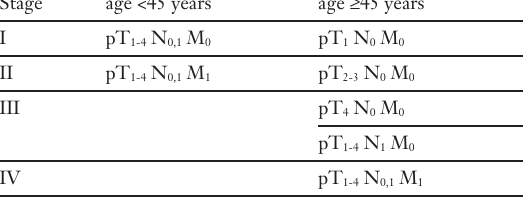
Age-related TNM classification